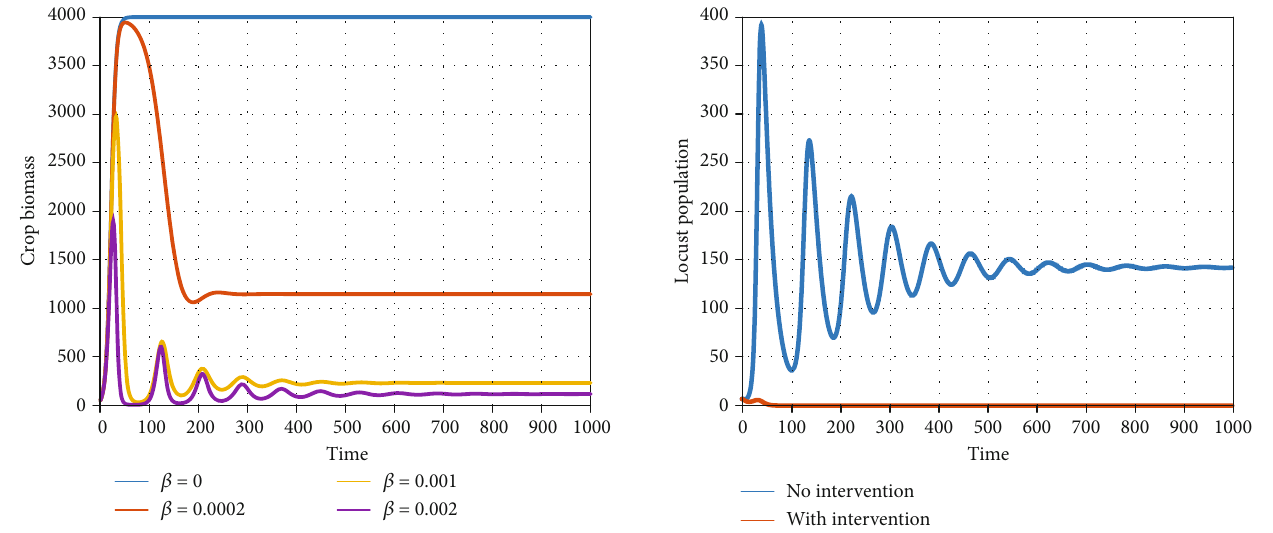
= γ = γ = 0 ) and within integrated 0 1 2 = 0 : 00025 , and γ = γ = 0 : 00225 ). 0 1 2